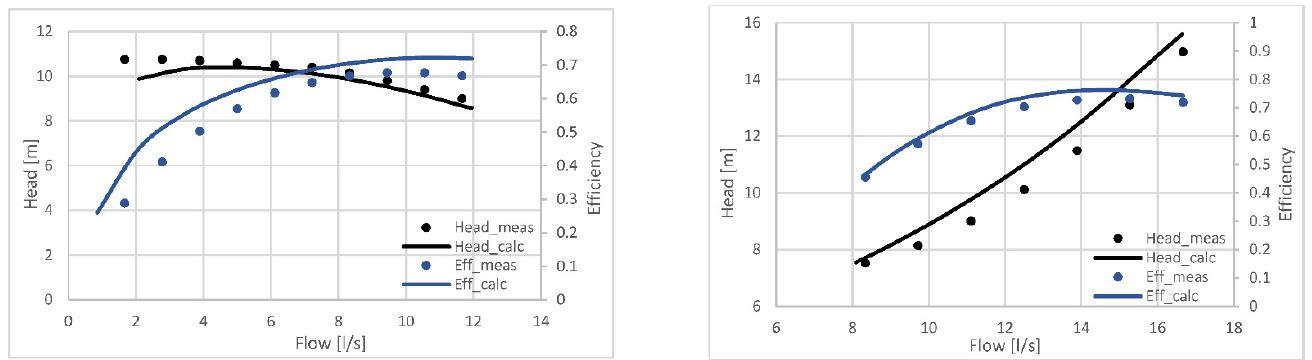
Figure 10. ( A ) Head and efficiency for the PAT 50-160 (ns = 31.01) in pump operation. ( B ) Head and efficiency for the PAT 50-160 (nst = 26.03) in turbine operation.